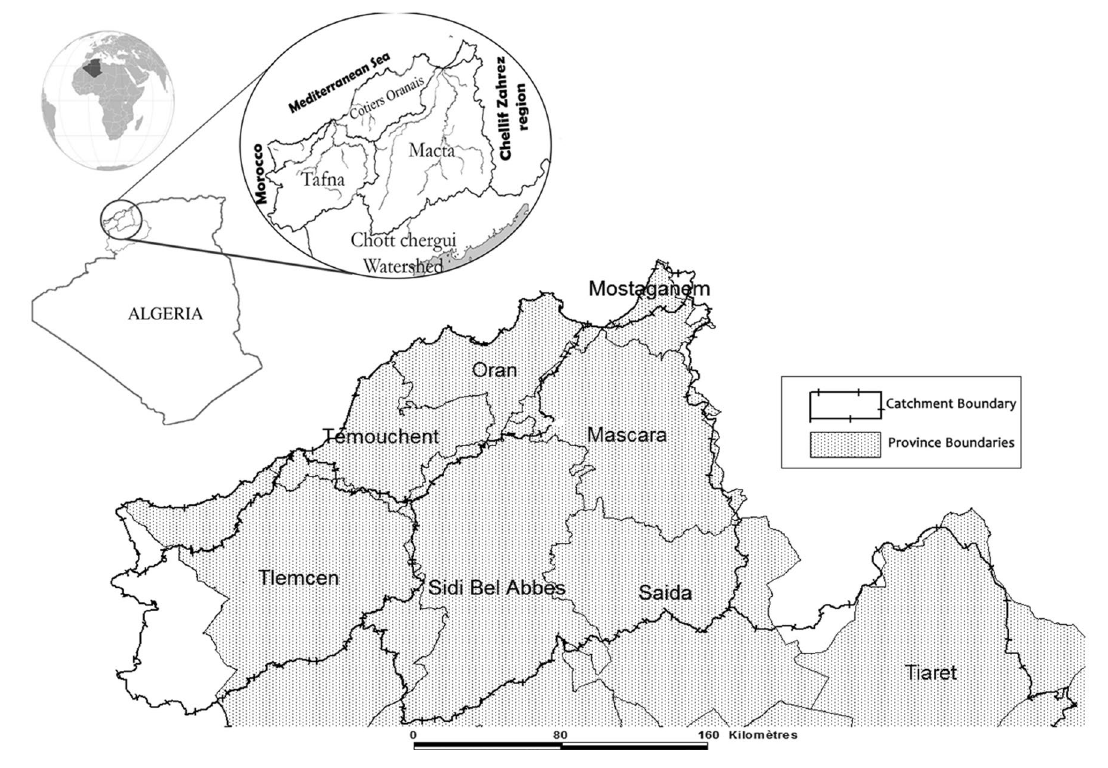
Fig. 1 Location of study